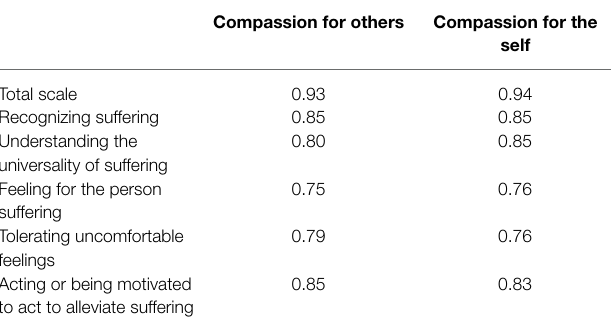
TABLE 2 | Cronbach’s alpha for SOCS-O and SOCS-S scale and subscale